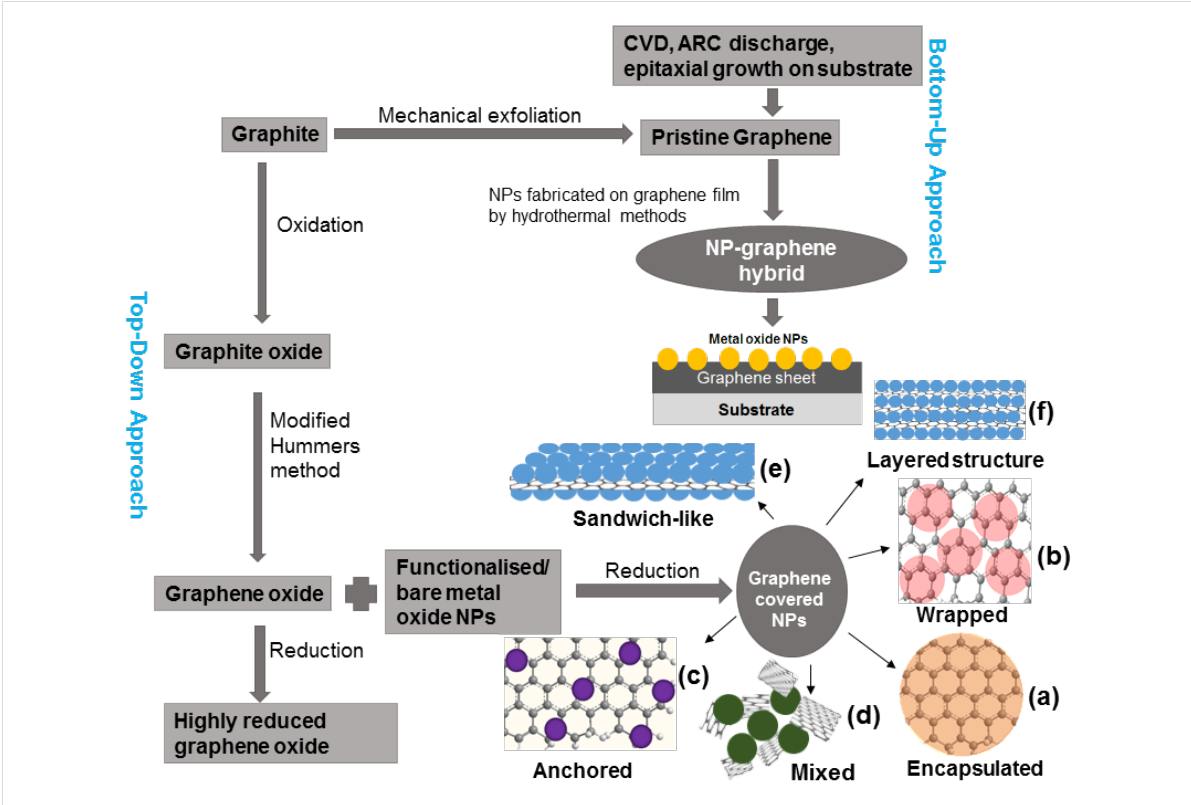
Figure 1: Schematic presentation of methods used for the formation of graphene–NP hybrids and different structures of (a) graphene-encapsulated NPs, (b) graphene-wrapped NPs, (c) NPs anchored to GSs, (d) mixed graphene–NP structures, (e) graphene–NP sandwich structures, and (f) graphene–NP layered